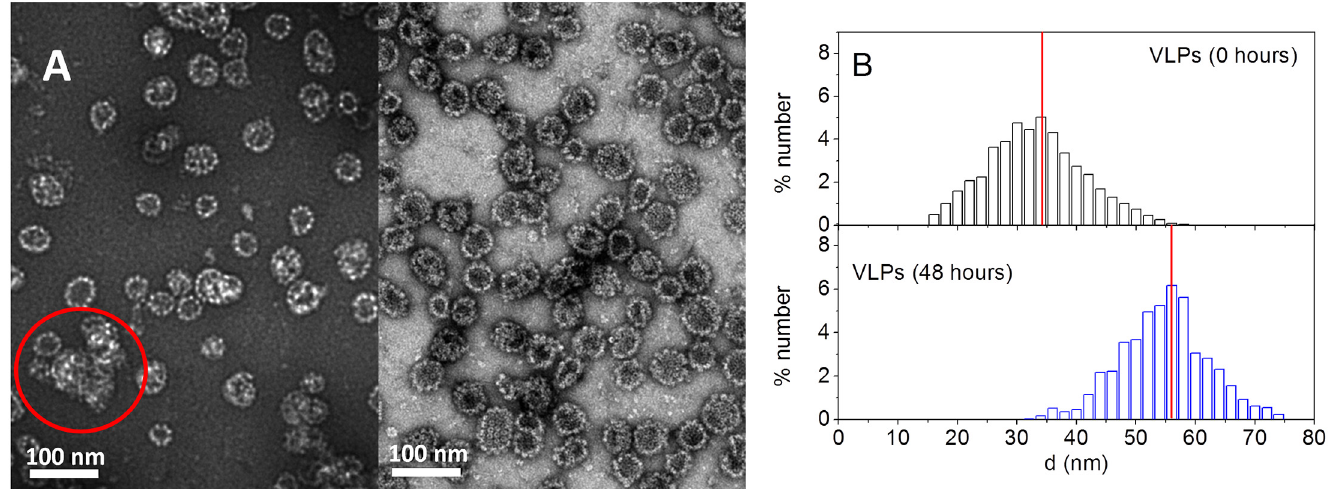
Fig 3. Virus-like particles before and after the stabilization process. (A) Transmission electron micrographs of HPV16 VLPs in the initial (left) and final states (right). (B) Number averaged size histogram obtained from the pictures. The vertical lines correspond to the number averaged results obtained from the DLS analysis and Eq